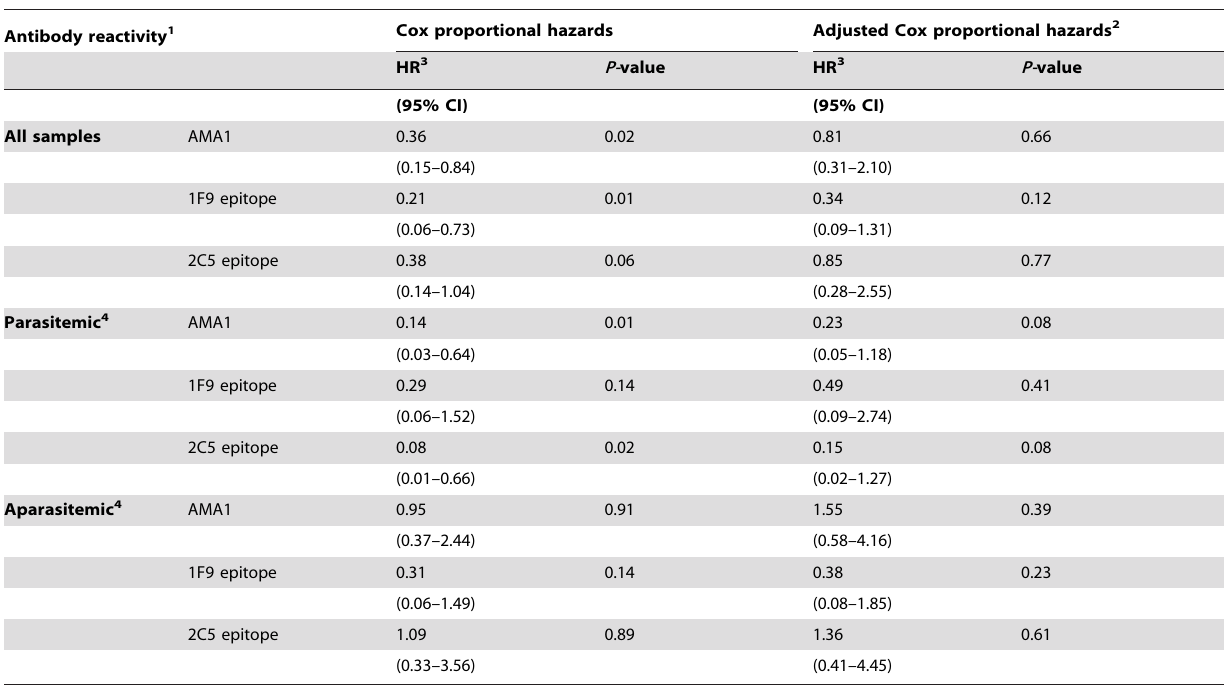
Table 1. Association between antibody responses and risk of clinical malaria in the Chonyi